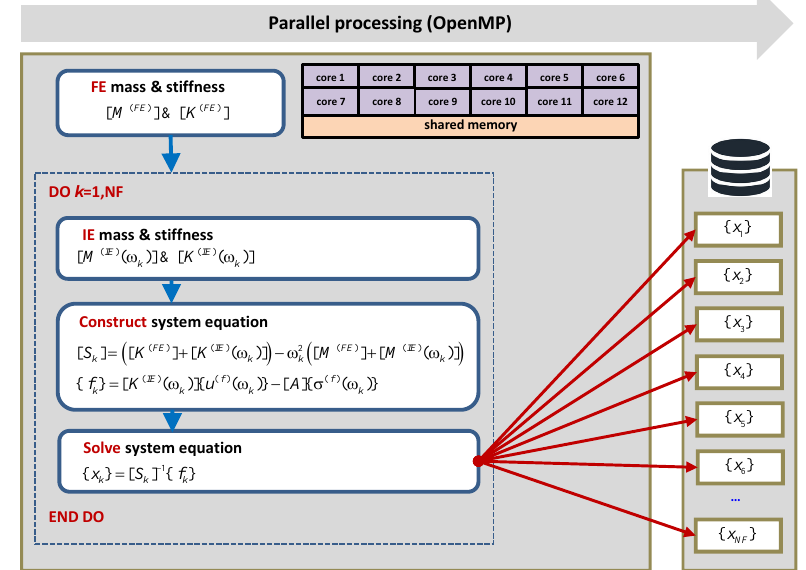
Figure 3. Conceptual analysis diagram of the existing KIESSI-3D. Appl. Sci. 2023 , 13 , 2356